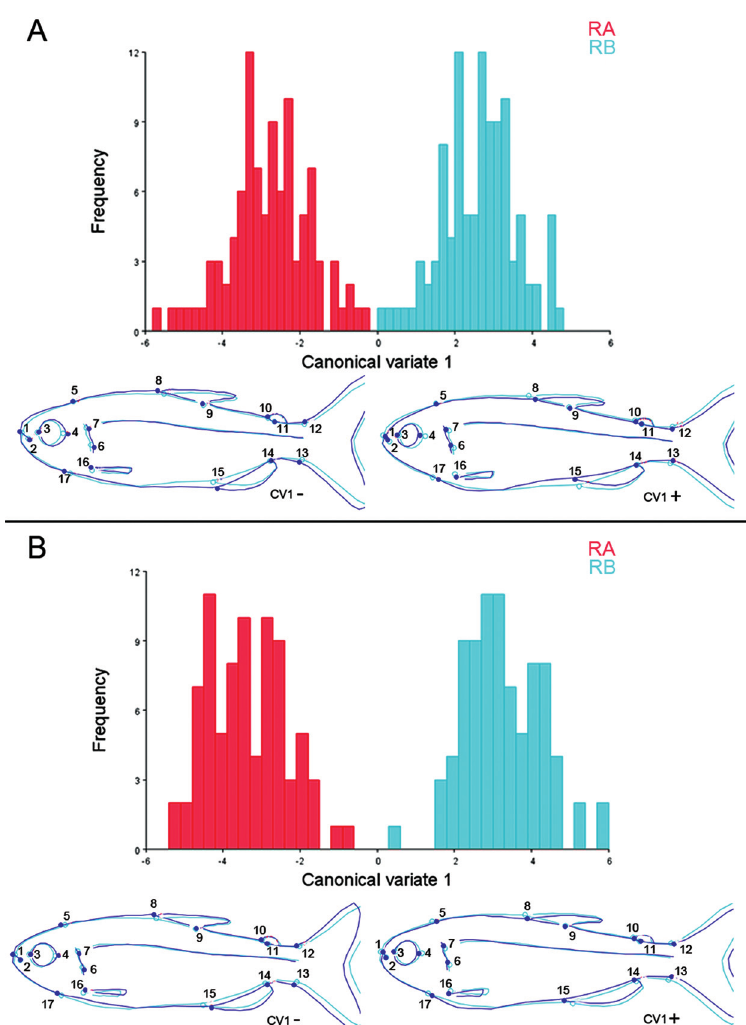
Fig. 3. Projection of Astyanax aff. scabripinnis individuals along the first two canonical axes. A: Projection of A. aff. scabripinnis females; B: Projection of A. aff. scabripinnis males. Shape deformations (dark line) for each CV axes are showed in relation to the reference configuration (light line). RA (red): Ribeirão Grande 662 m a.s.l.; RB (blue): Ribeirão Grande headwaters 1850